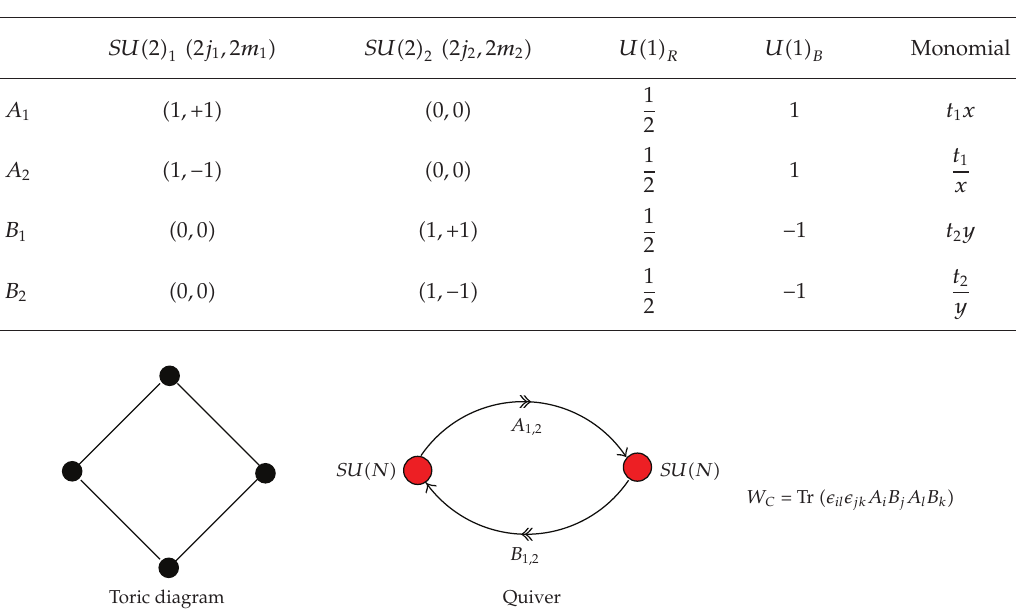
Table 1: The transformation, under the explicit global symmetry group SU (cid:7) 2 (cid:8) of the 4 fields in the conifold theory. The monomials indicate the associated chemical potentials in the Plethystic programme.